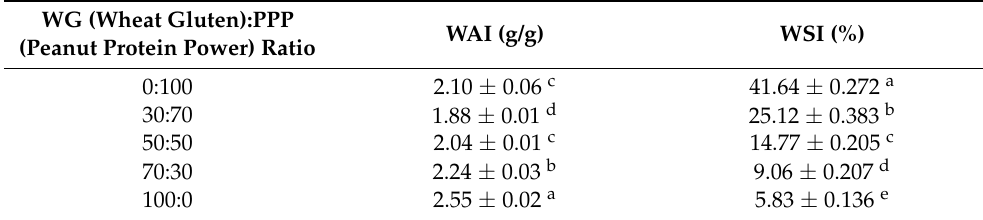
Table 1. Water absorption index (WAI) and water solubility index (WSI) of different raw